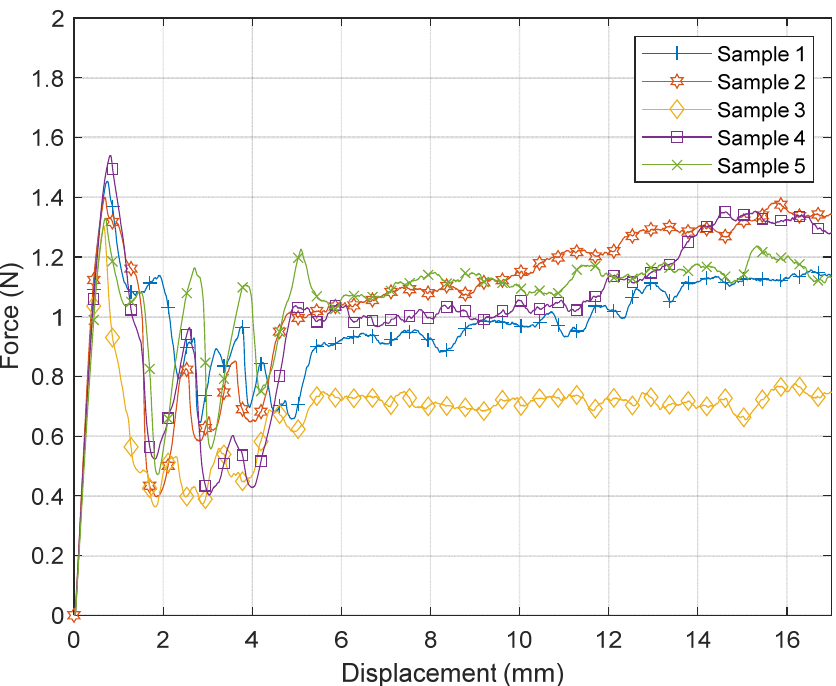
Figure 9. Debonding force measurement of the scotch tape.